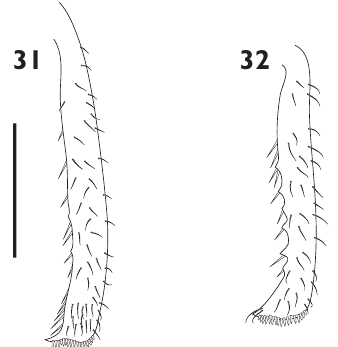
Figures 31–32. Left protibia, anterior view. 31 Austromonticola inflatus , holotype 32 Austromonticola planulatus , holotype. Scale bar = 1